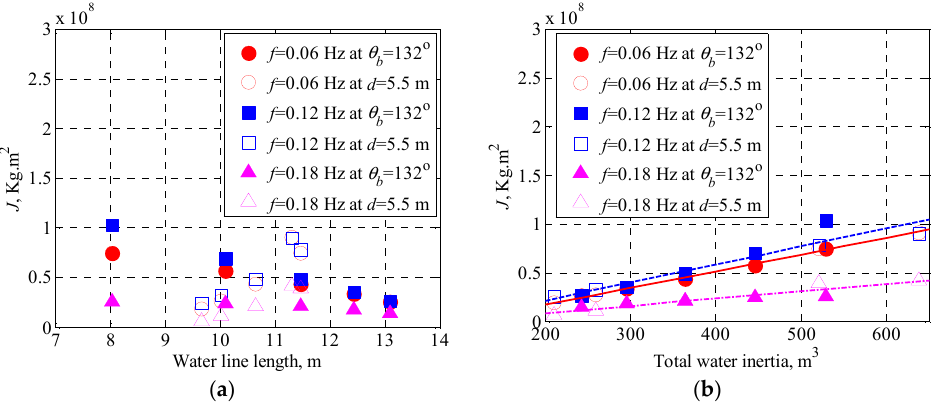
( b ) Figure 6. Demonstration of the water inertia: ( a ) the flow pattern of a small piece of water near the wetted Duck surface; and ( b ) distribution of the water inertia along the wetted Duck surface at d = 5.5 m and θ b = 144°. Figure 7 shows the radiation damping coefficient as a function of wave frequency at different floating states. The radiation damping coefficient increases with beak angle monotonously when θ b = 144° and also increases with beak angle when d = 5.5 m and a little exception is observed for beak angle of 156° at frequencies around 0.2 Hz, where the radiation damping coefficient decreases with